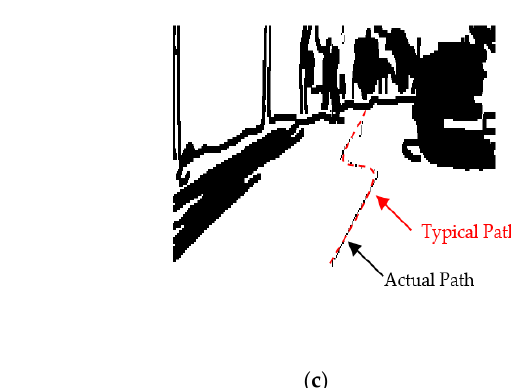
image processing, and ( c ) generation of the path within the road following environment.